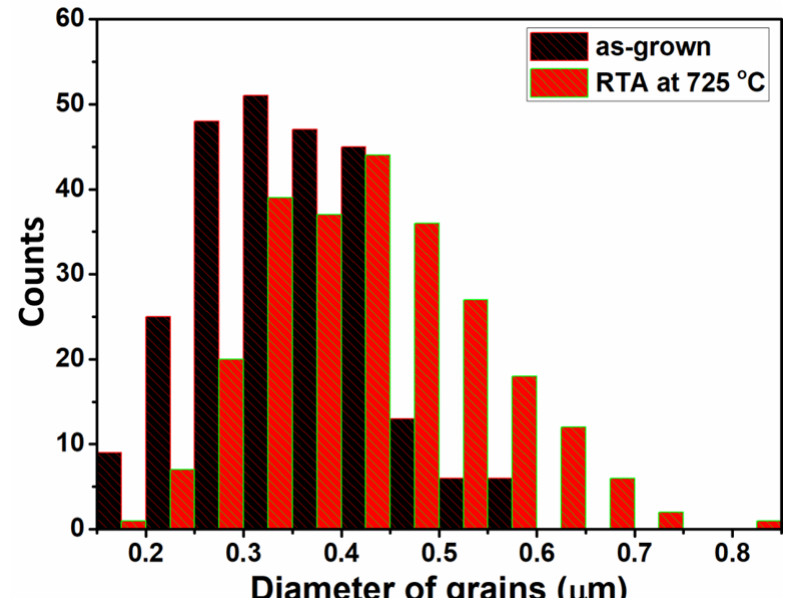
Figure 3. The grain diameter distribution for as-grown and RTA treated ZnO:Sn nanostructured